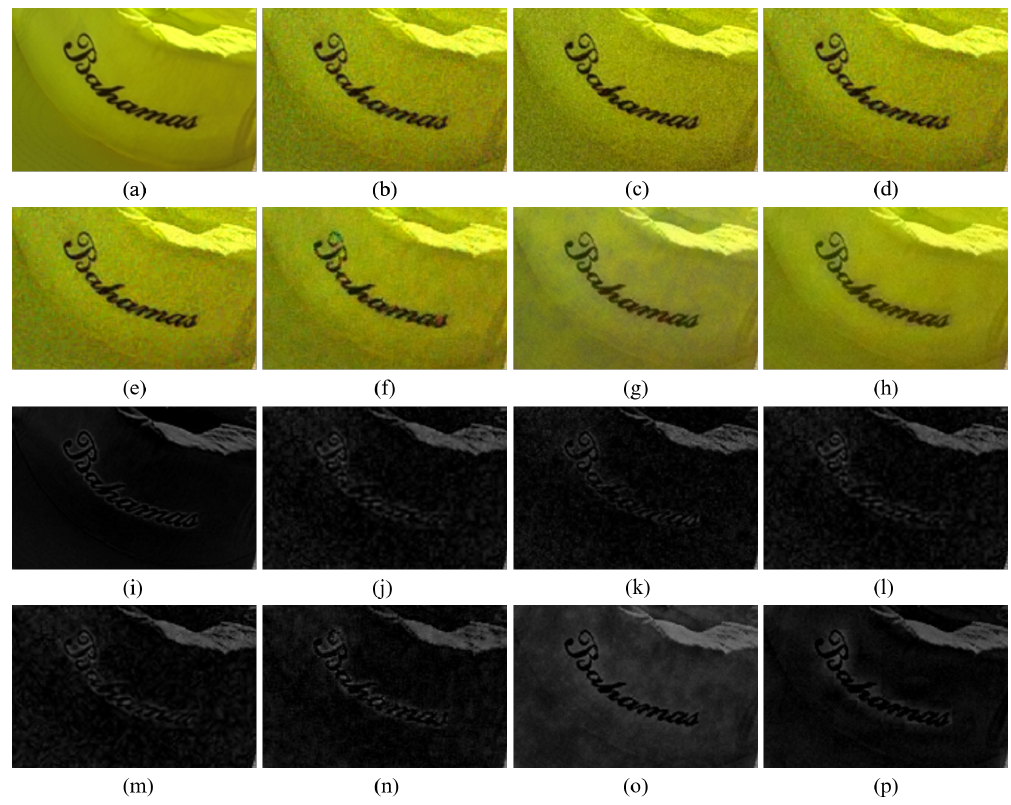
Figure 10. Demosaicing results when one channel has low intensity values. The first and the second rows show the reconstructed color images, while the third and the fourth rows show the Blue